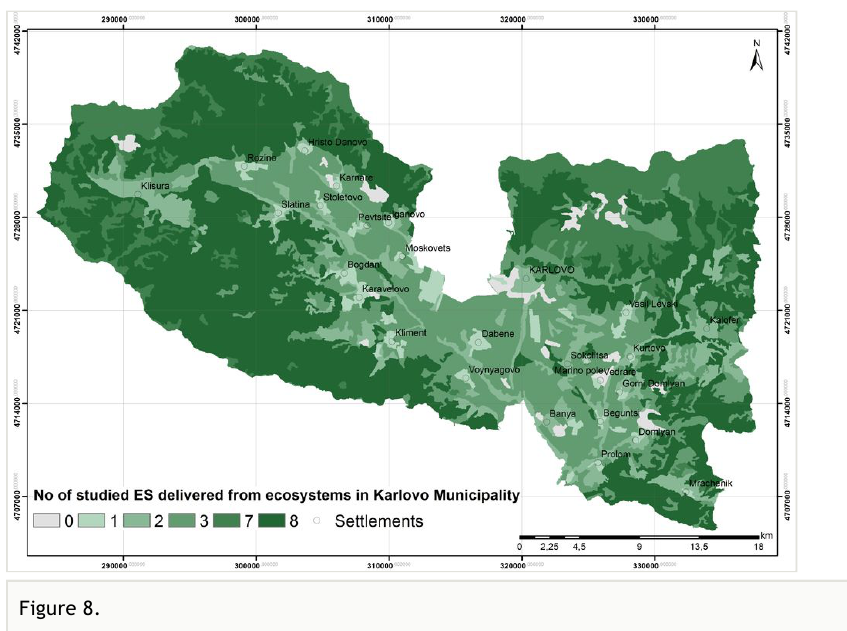
Figure 8. Hotspots of Ecosystem Services in Karlovo